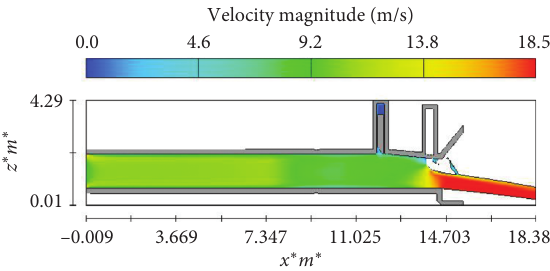
Figure 14: Output velocity of the gate and valve in 60% gate and 100% valve opening.